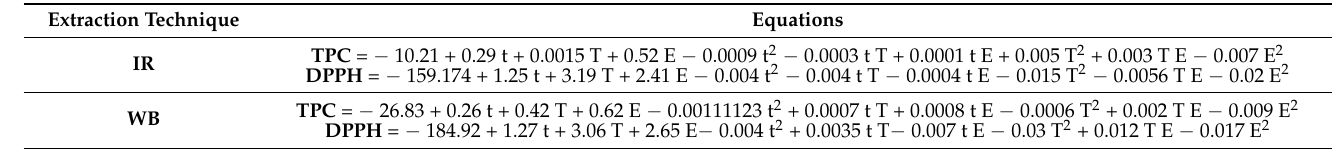
Table 2. Second-order regression equations for IR and WB